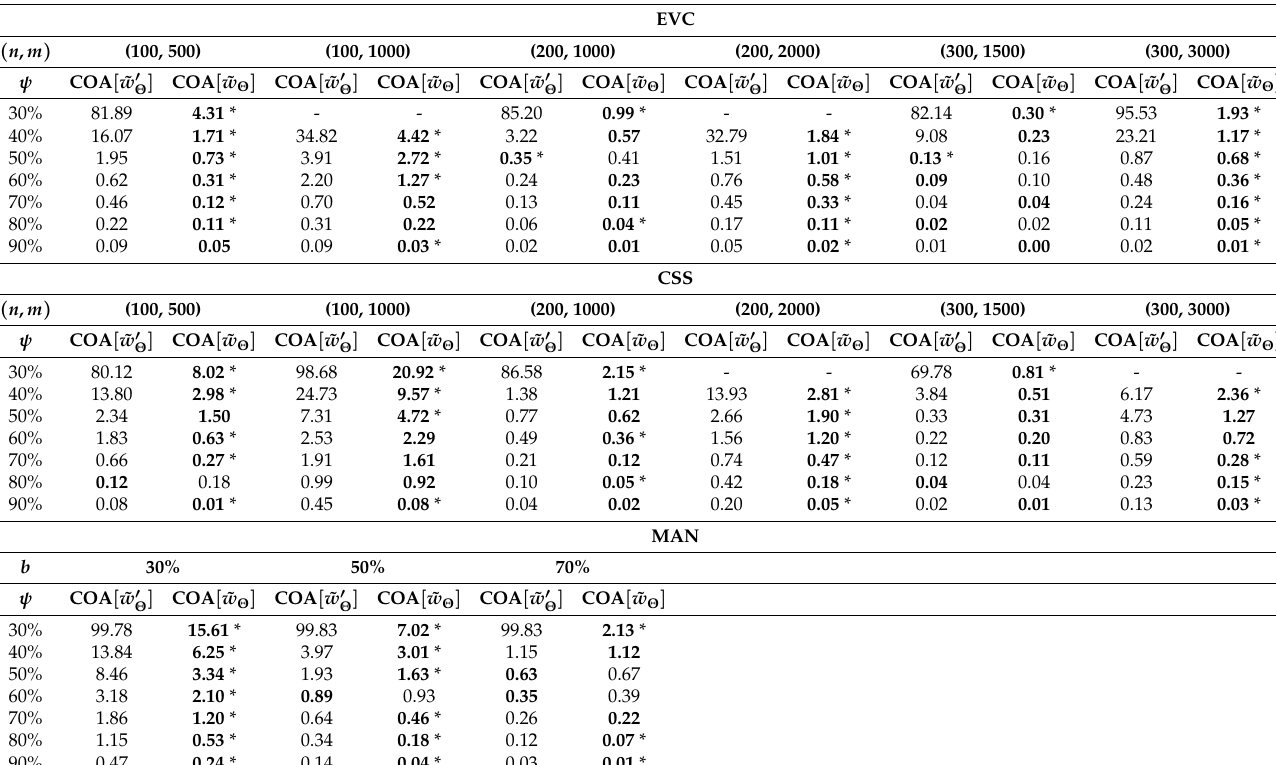
Table 3. Average optimality gaps of solution from COA [ ˜ w Θ ] and COA [ ˜ w (cid:48) Θ ] , where the latter utilizes the former surrogate function ˜ w (cid:48) Θ from Reference